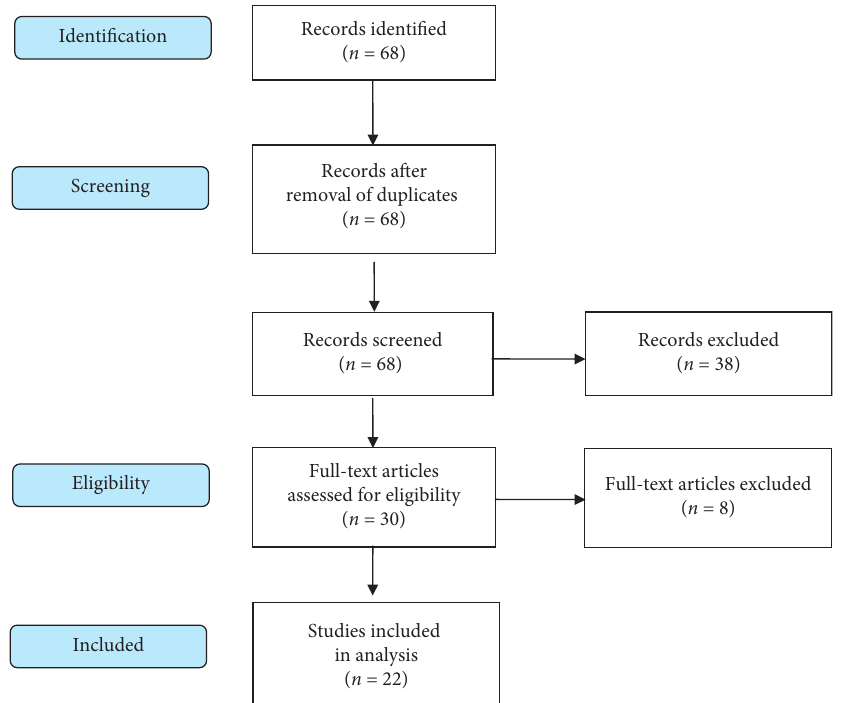
Figure 1: Research flowchart according to PRISMA